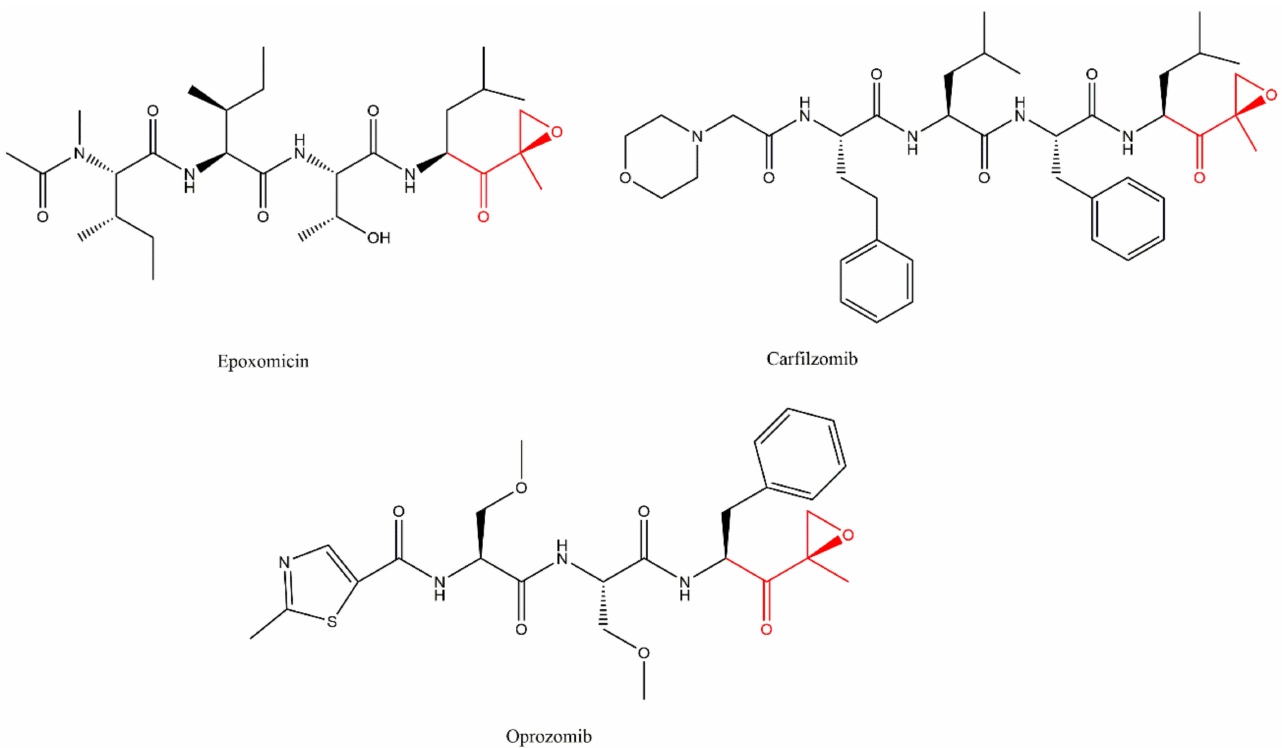
Figure 10. Examples of α ’, β ’-epoxyketone inhibitors of 20S CP